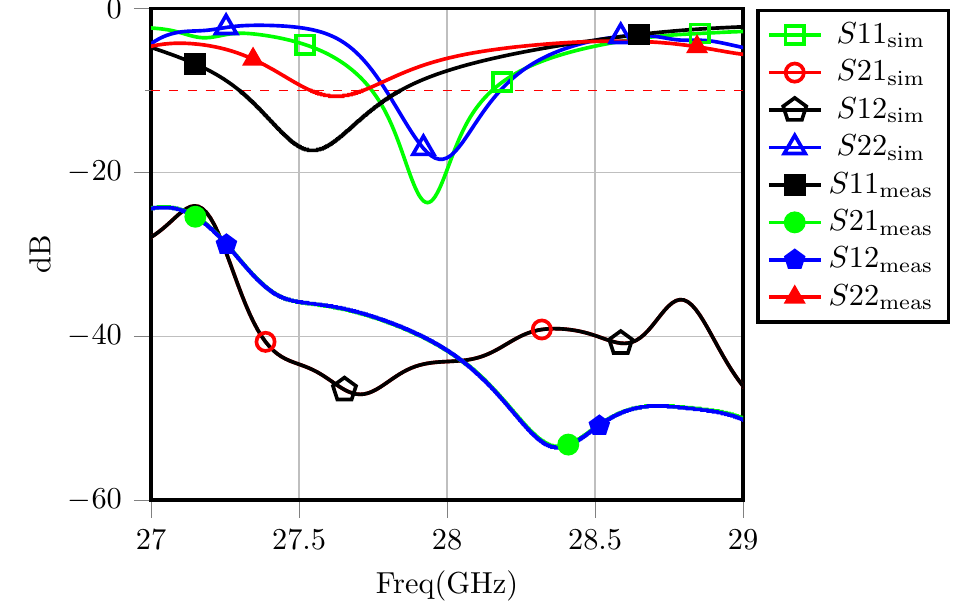
Figure 11. S-parameters of SIW antenna